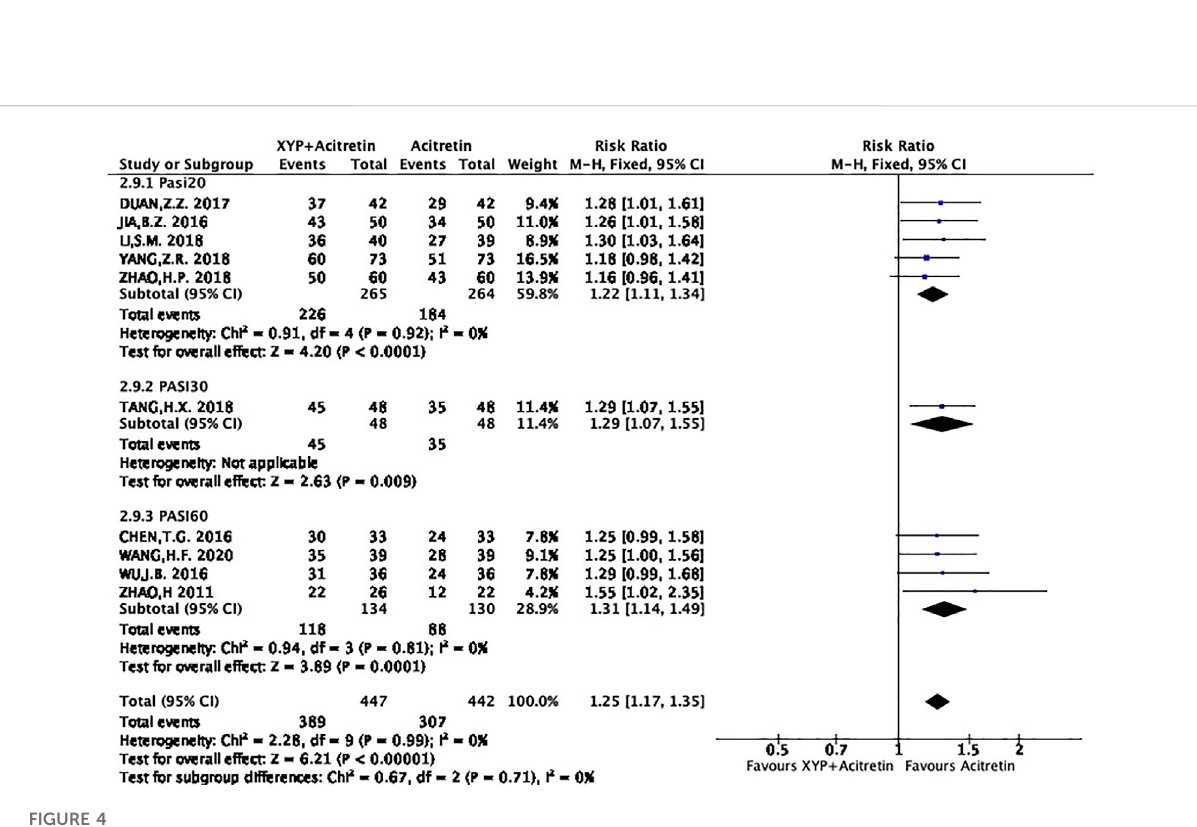
FIGURE 4 Forest plots showing RR for Total effective